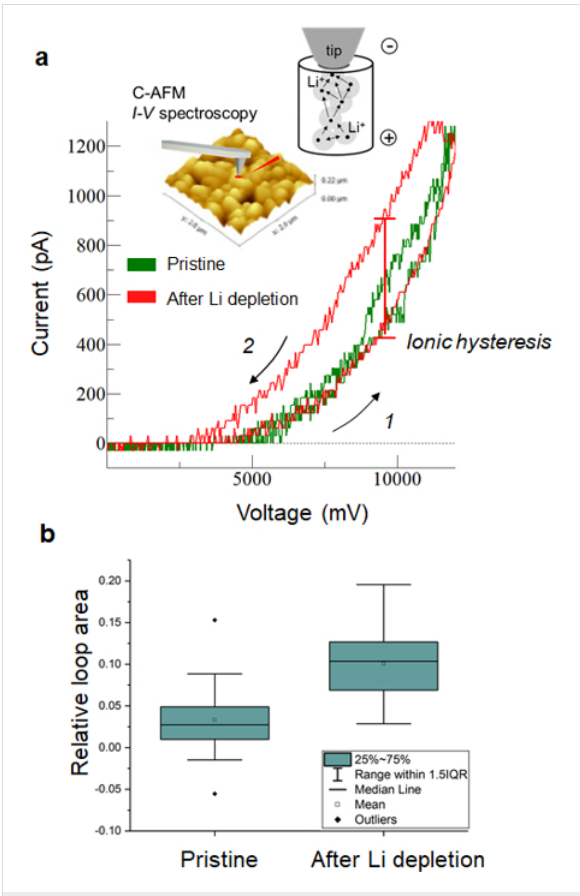
Figure 3: Appearance of the ionic hysteresis and influence of Li deple- tion during preconditioning. (a) The hysteresis loop visible in the I – V curves is indicating the local change in resistance under the tip in- duced by the Li modulation. The inset shows a schematic of the migra- tion of Li ions towards the AFM tip. The measurements were per- formed on RF-sputtered LMO under high vacuum at a sweep rate of 0.2 Hz. (b) An enhanced hysteresis loop opening, i.e., electrochemical response, can be observed due to a preconditioning dc scan (10 V) performed to deplete the lithium before the I – V curves are measured. The boxplot shows the distribution of the relative loop area (area enclosed by the loop and divided by the peak current